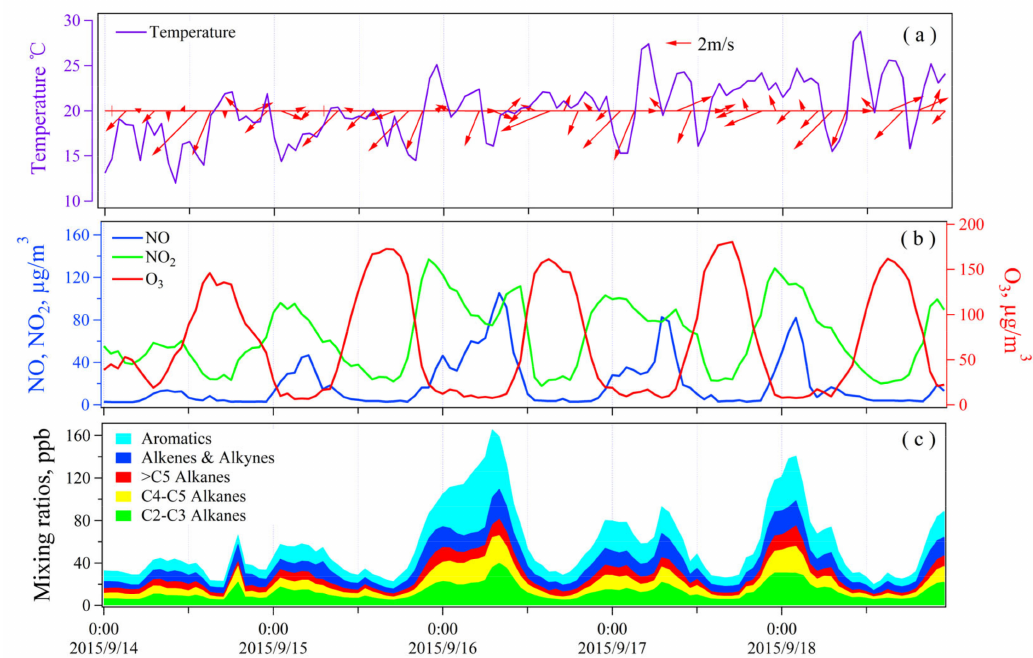
Figure 10. Time series of ( a ) wind and temperature, ( b ) concentrations of NO, NO 2 , and O 3 , and ( c ) mixing ratios of NMHCs during September 14th–18th, 2015.